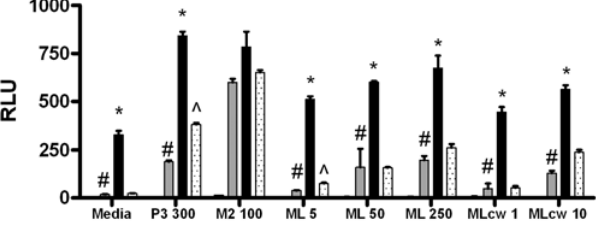
Figure 1. NF- k B activity in response to M.leprae is diminished in the 1805T variant. HEK293 cells were transfected with an NF- k